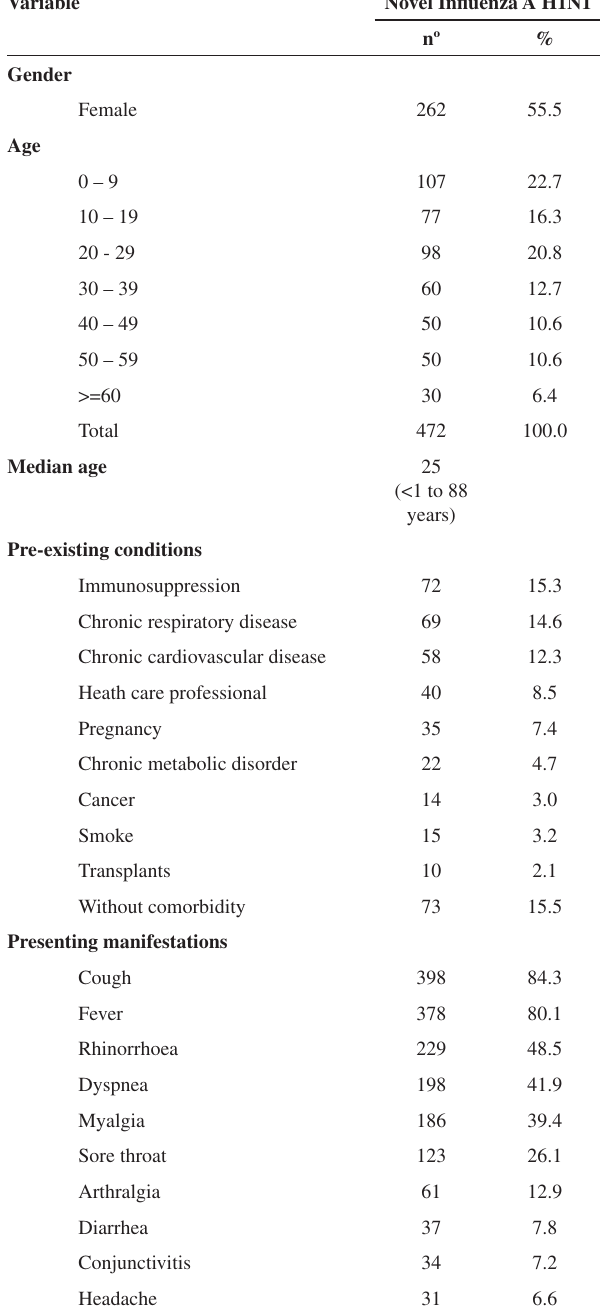
Table 2 - Clinical and epidemiologic aspects of 472 con- firmed cases of novel Influenza A (H1N1) - Hospital das Clinicas FMUSP - June 16 to September 18,